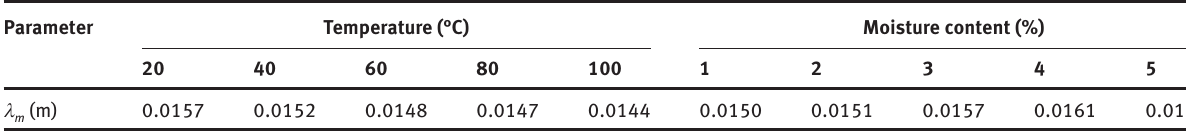
Table 1: The microwave wavelength in petroleum coke over the moisture content of 1% to 5% at 20 °C and petroleum coke (10% moisture content) in the temperature range of 20 °C to 100 °C at 2.45